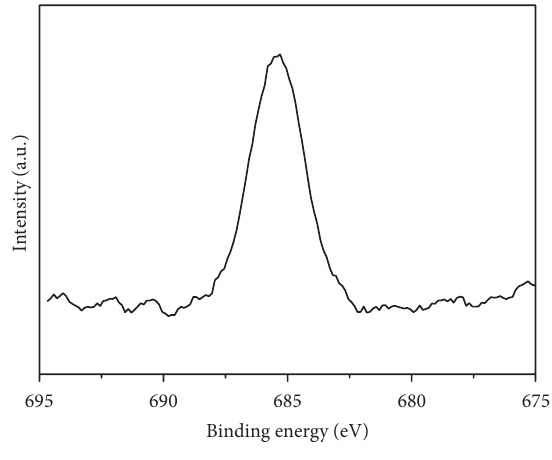
Figure 2: XPS spectrum of F1s.